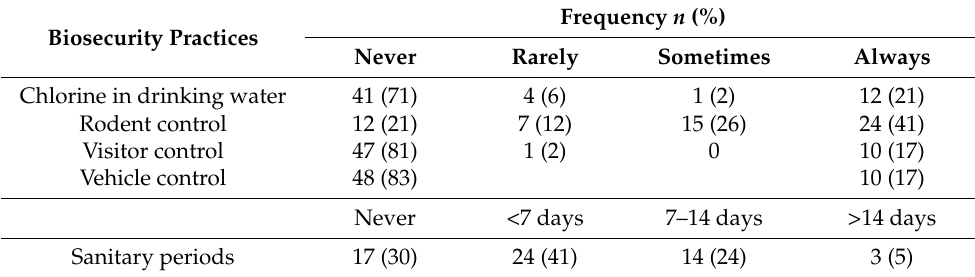
Table 3. Biosecurity practices adopted by the farms